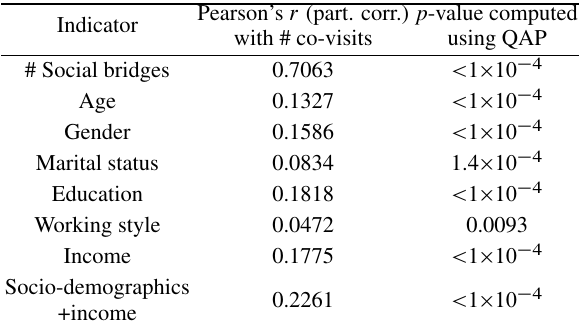
Table 1 Social bridges, which are the pattern of physical interaction between neighborhoods, predict purchasing and financial decisions three times better than traditional demographics [25]